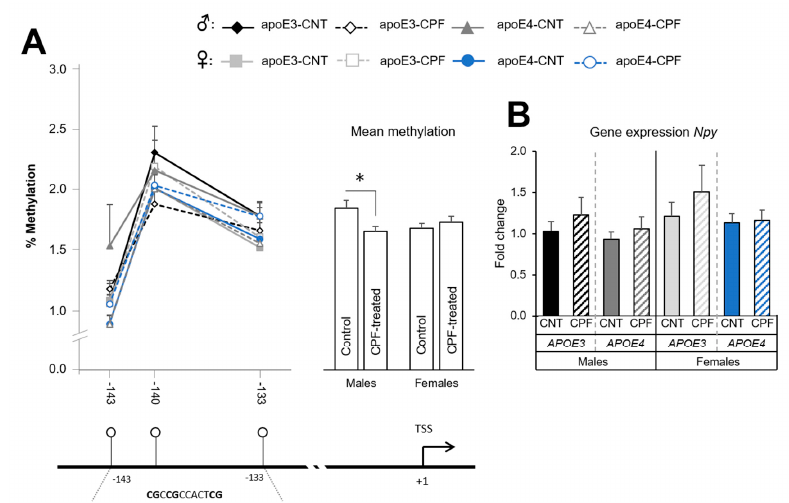
Int. J. Environ. Res. Public Health 2021 , 18 , x Figure 3. Npy gene methylation at the CpG positions studied in the target zone in the promoter and overall methylation levels, which are sharing the same y axis. Below, there is the graphical representation of the CpG positions studied and the exact sequence of the target region ( A ). Gene expression of the Npy gene ( B ). All groups included 6 animals except for the APOE3 -CNT that included 5. An asterisk (*) indicates significant differences between groups at p < 0.05. Abbreviations: CNT, control; CPF, chlorpyrifos-treated. Data is contained within the Supplementary File S1.